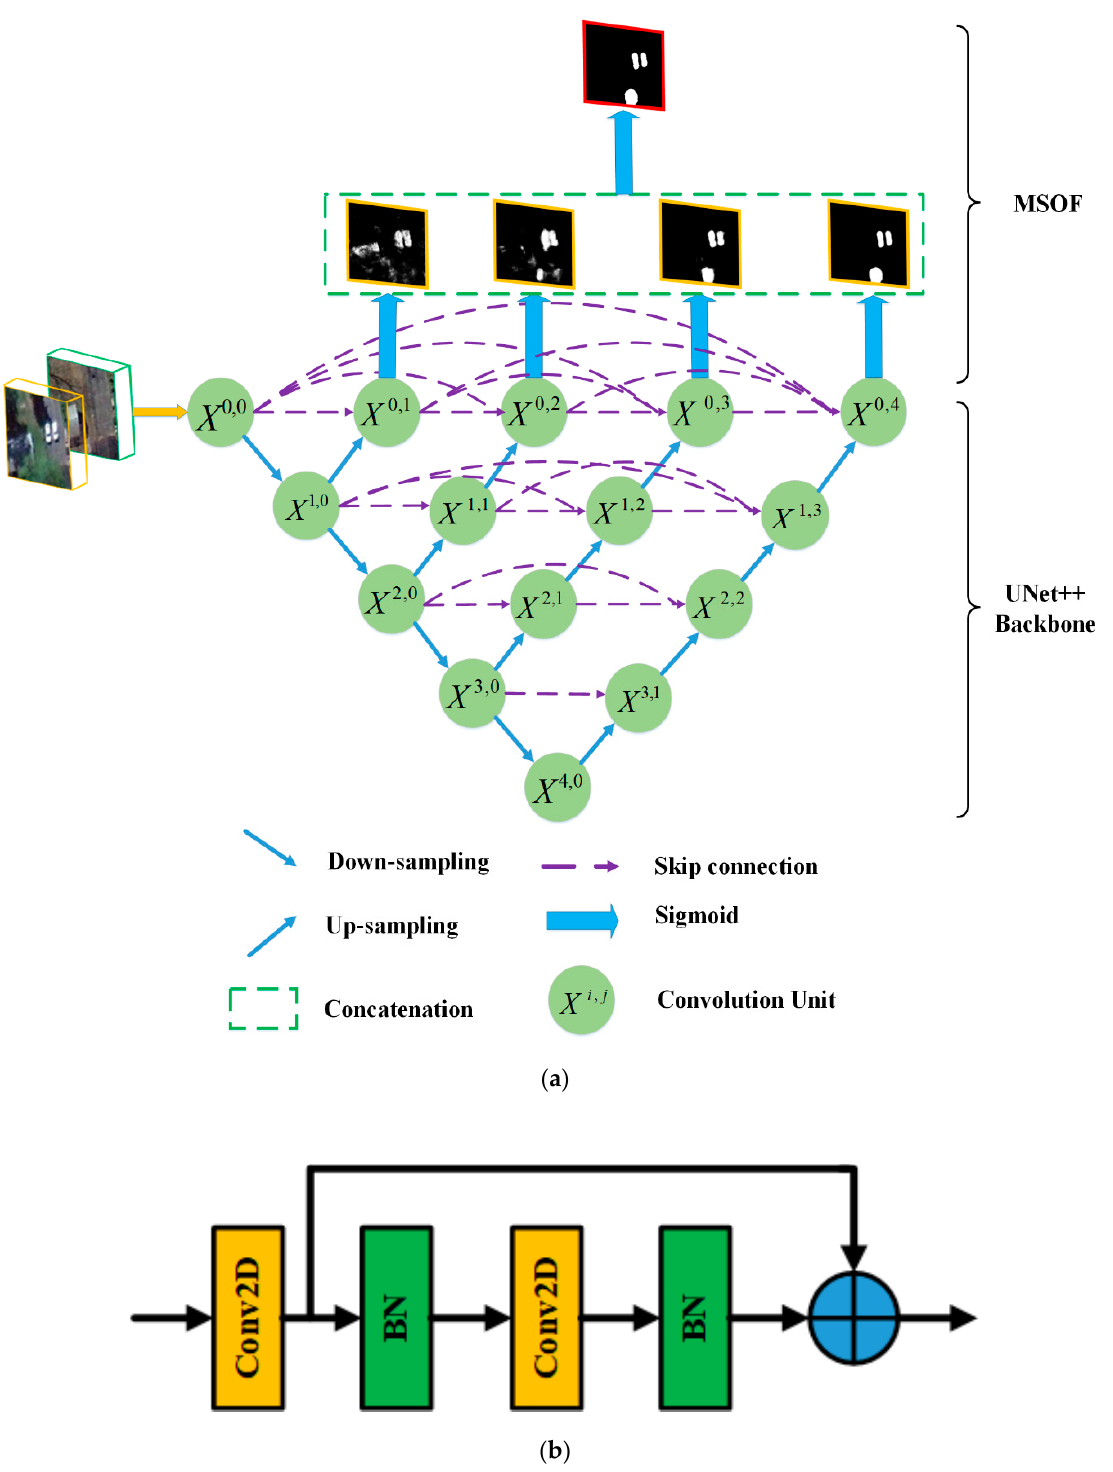
Figure 2. Flowchart of the proposed method: ( a ) illustration of the main flowchart; ( b ) illustration of the convolution unit.